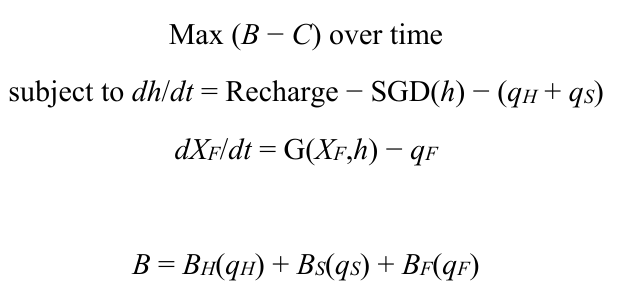
Figure A2. Groundwater optimization model for Obama City,